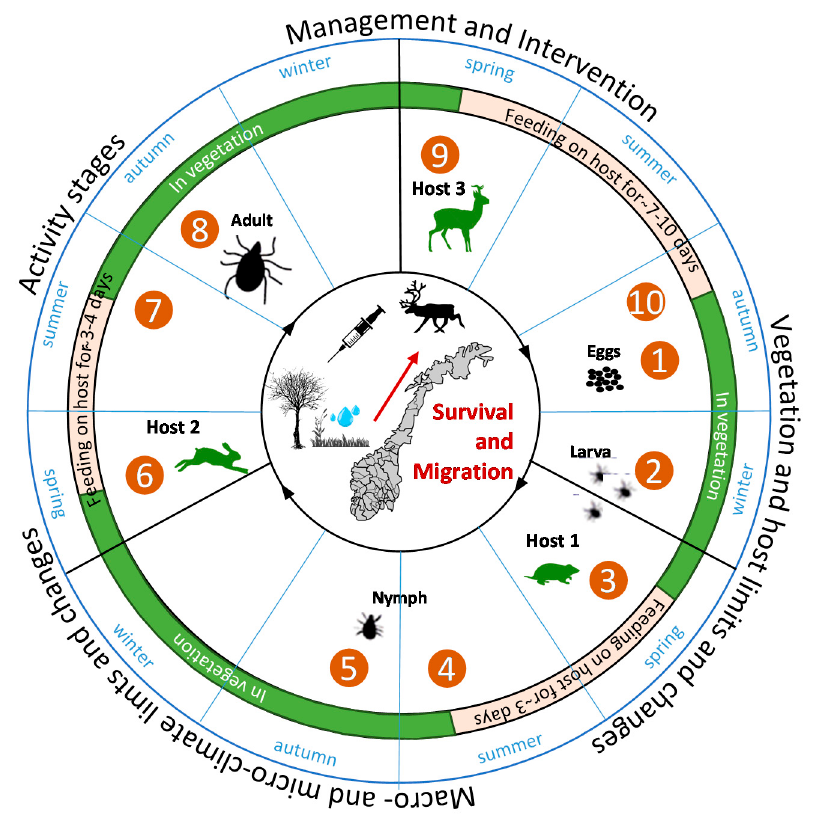
Figure 1. The Ixodes ricinus (tick) life cycle and linkages to its environment: Development, inactive (overwintering) and active (questing and on host) stages, climate limits and changes, preferred hosts and vegetation, and management and interventions all form boundaries for the survival and migration of ticks and the CSIs they carry. Descriptive cycle text nos. 1–10 based on www.cdc.gov/dpdx/ticks/index.html.